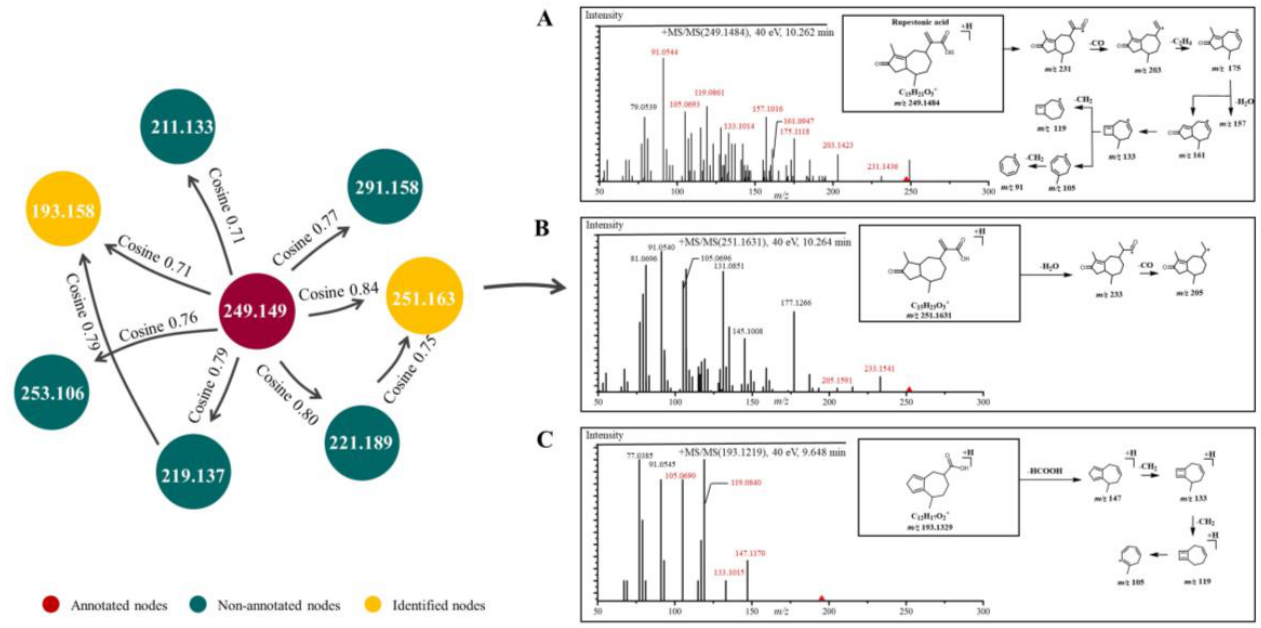
Figure 9. Mass spectrum and proposed fragmentation patterns of rupestonic acid ( A ), compound 2 ( B ) and compound 4 ( C ).